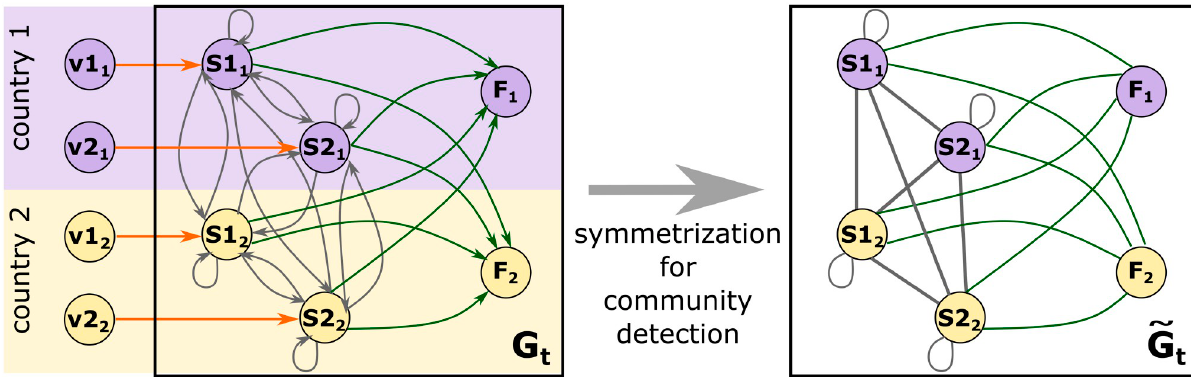
Fig 2. A two-sector two-country world economy network [14]. Node Si j ( i , j = 1, 2) is country j sector i ; F j ( j = 1, 2) is country’s j final demand, and vi j ( i , j = 1, 2) is the value-added of country j sector i .